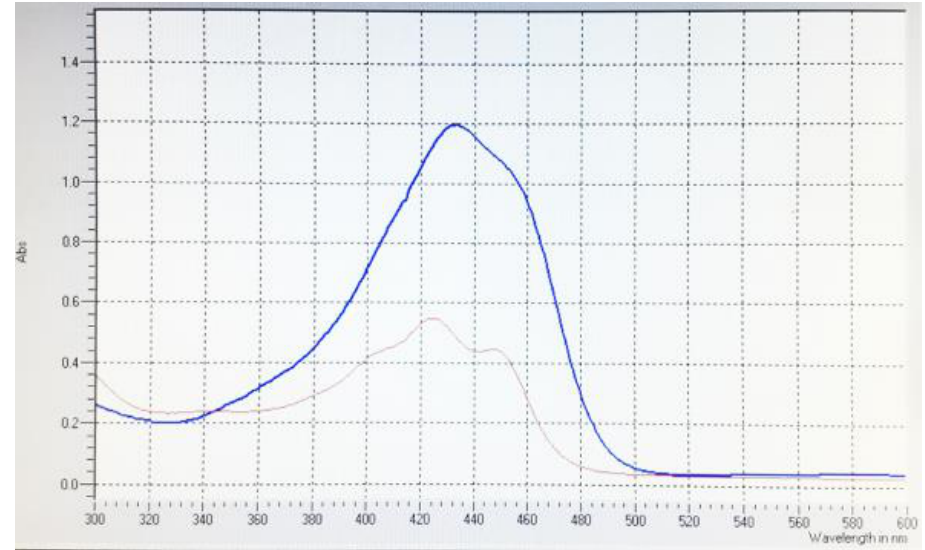
Figure 3. Curcumin (blue) and mitocurcumin (red) spectra at the same concentration (10 µ